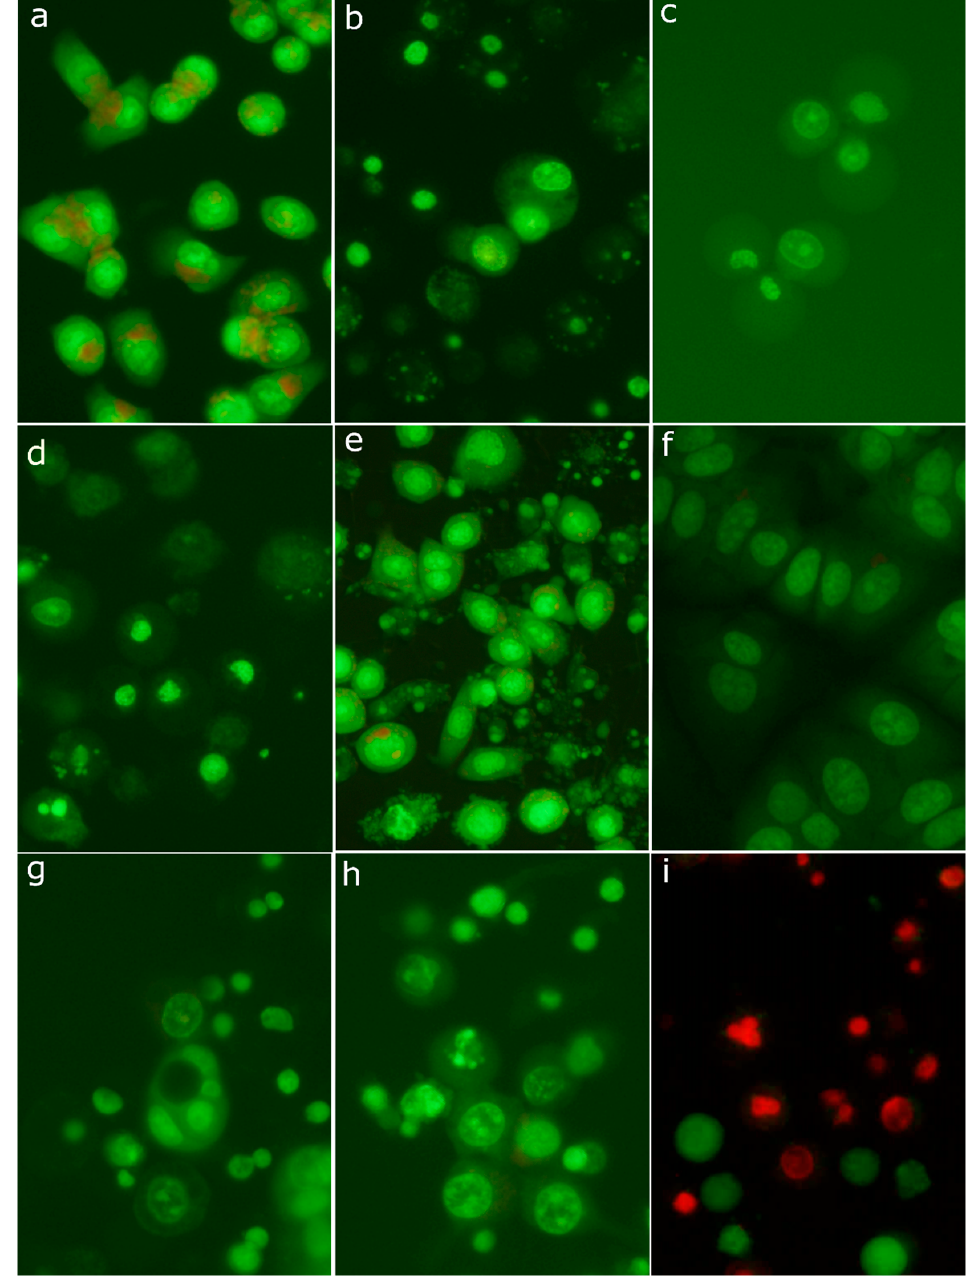
Figure 8. Morphology of SK-BR-3 cells stained with acridine orange: control cells ( a ); cells treated with 10 µM compound 4 for 24 h ( b ); cells treated with 30 µM compound 4 for 6 h ( c ); cells treated with 30 µM compound 4 for 24 h ( d ); cells treated with 20 mM sodium butyrate (positive control) ( e ); morphology of MCF-7 cells stained with acridine orange: con- trol cells ( f ); cells treated with 10 µM compound 4 for 24 h ( g ); cells treated with 30 µM compound 4 for 24 h ( h ); effect of compound 4 (30 µM, 24 h) on SK-BR-3 cell viability assessed using the Live/Dead Viability/Cytotoxicity Kit ( i ). Nuclei of SK-BR-3 cells stained with acridine orange after 6 h treatment with 30 µM compound 4 presented two variants of morphological changes: some of them were dis- tended and weakly stained, whereas others were rather shrunken and condensed (Figure 8c). After a 24 h treatment period, distended nuclei seemed almost completely degraded, whereas condensed nuclei appeared largely unchanged. In numerous cells, green clumps scattered in the cytoplasm were visible (Figure 8d). The morphology of some cells with